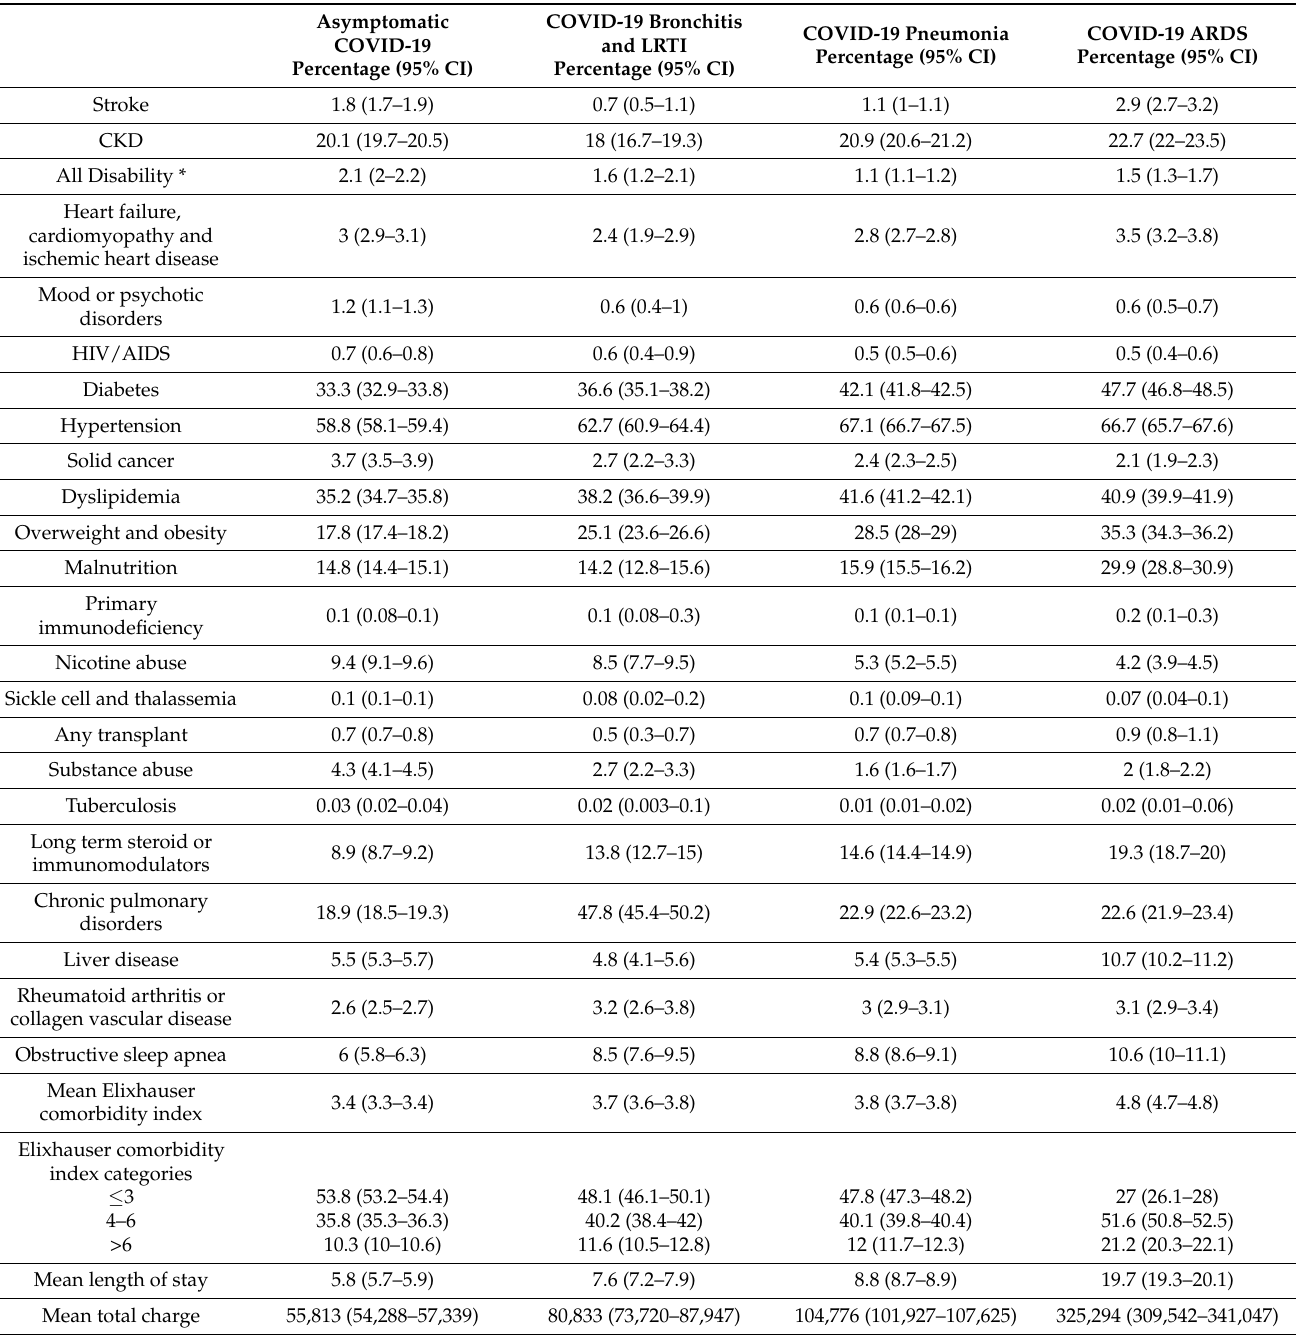
Table 2. The proportion of Comorbidities in